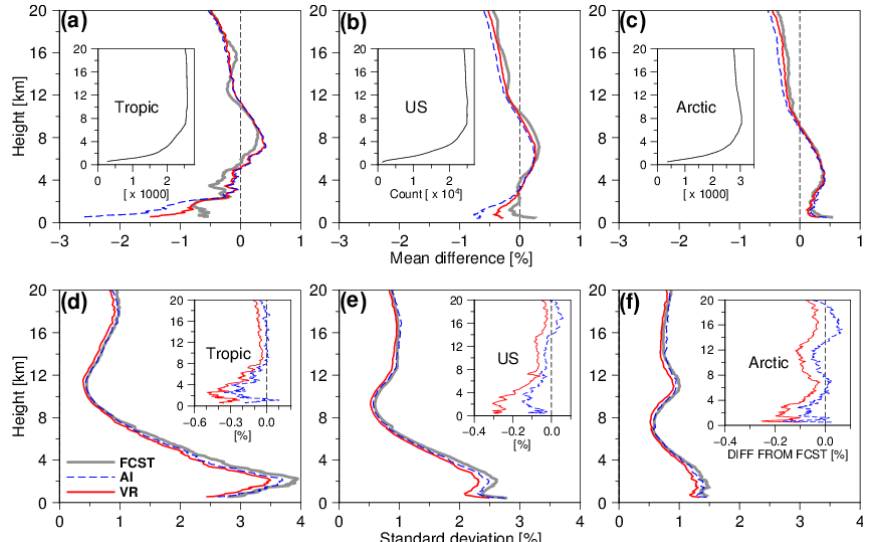
Figure 12. Comparison with collocated HVRRD. (a–c) Mean difference (%) from HVRRD of CDAAC’s refractivity derived via Abel inversion (dashed blue line, denoted AI), ECMWF’s 24h forecast (heavy solid grey, FCST), and VR-produced refractivity (solid red) for which the FCST is used as the background. Shown are the statistics over (a) the tropics, (b) the US, and (c) Alaska. The insets show the vertical data counts. (d–f) The same as in panels (a–c) except for the standard deviation. The insets show the differences from FCST in the standard deviation from